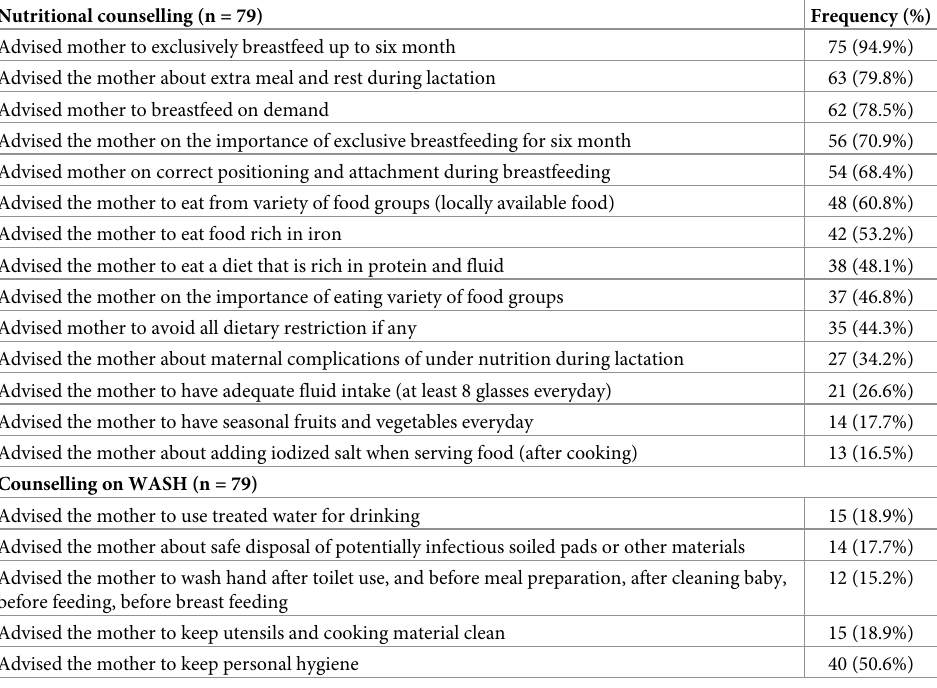
Table 8. Proportion of mother receiving nutritional counselling at postnatal care service provision